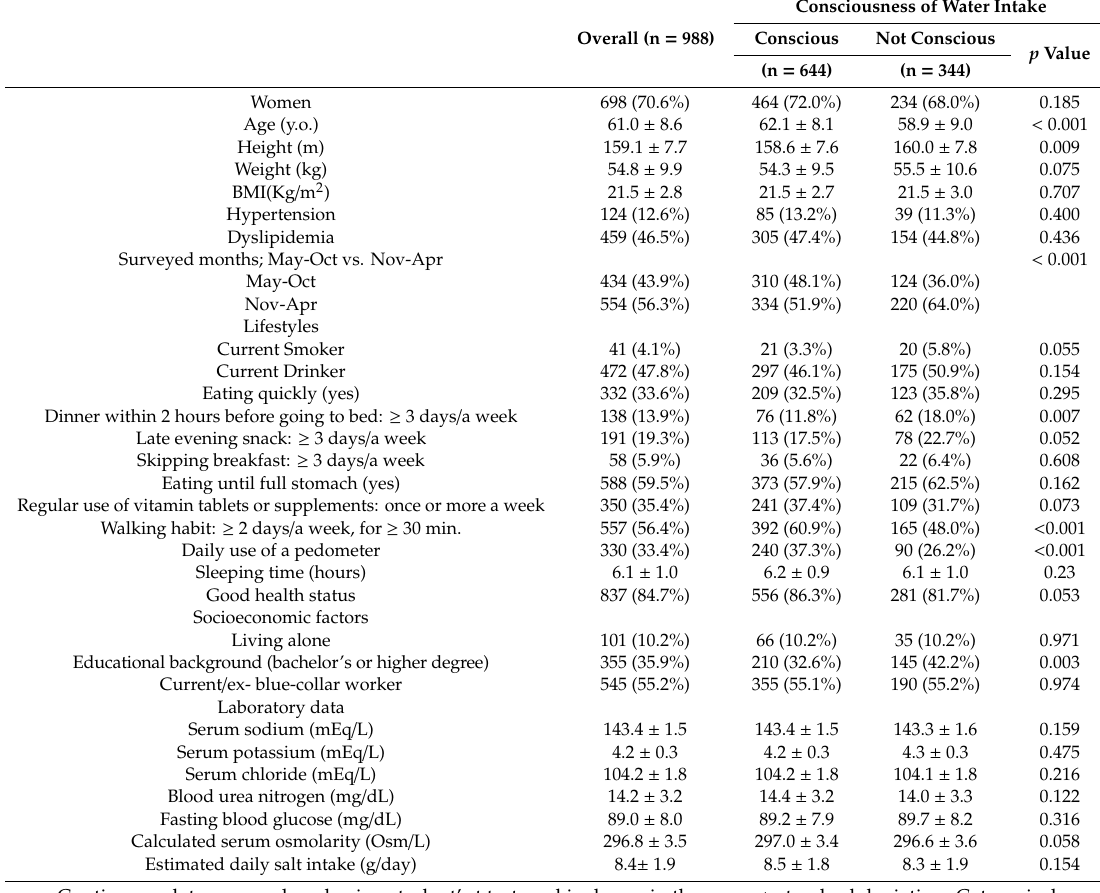
Table 1. Characteristics Demographic by consciousness of water